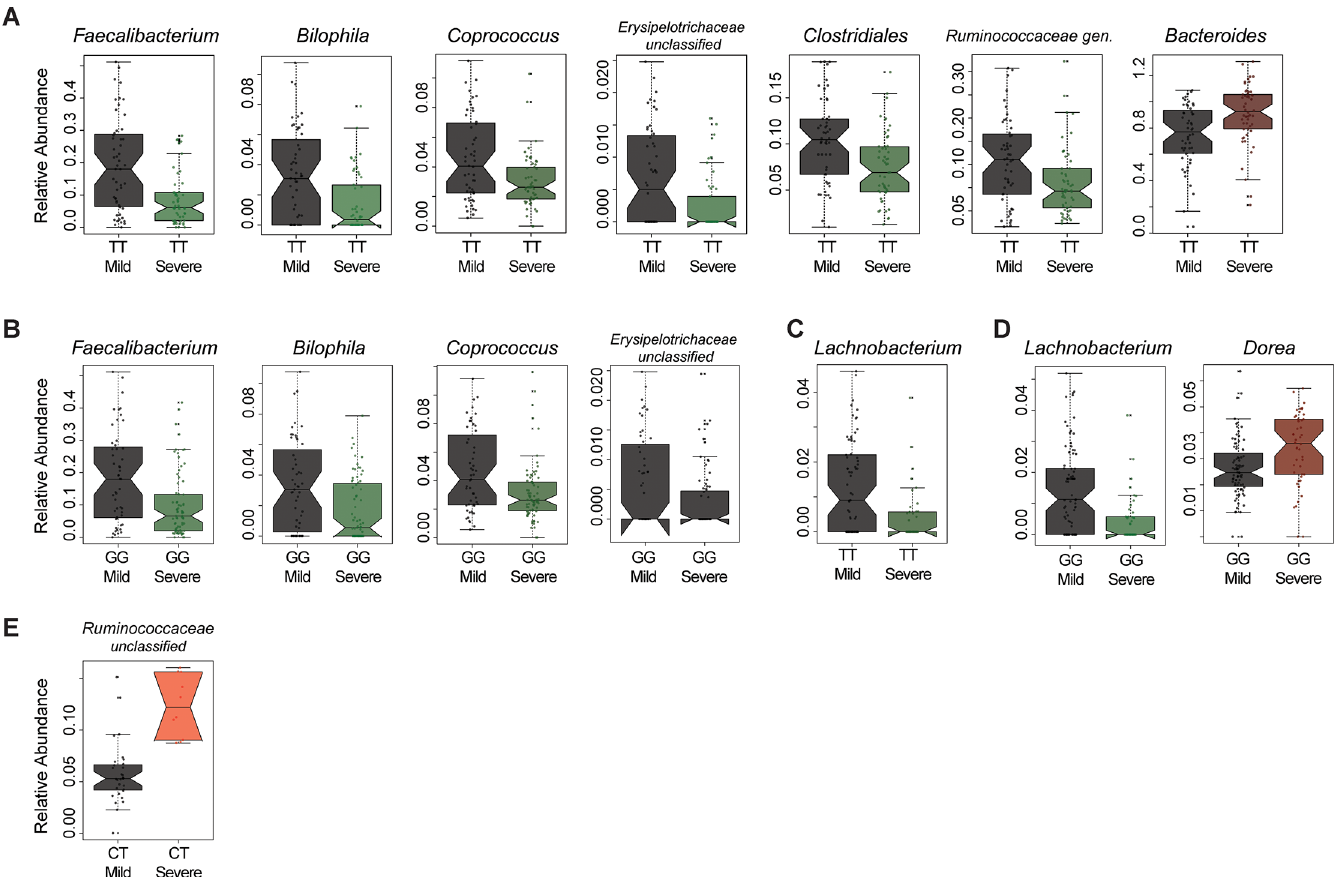
Fig 3. The microbial differences associated with disease severity within same PTPN disease variants. The relative abundance of significantly different microbial taxa (q < 0.05) were plotted according to disease severity status for PTPN2 wild-type variant in (A) and PTPN22 wild type variant in (B) when analyzed for CD. The relative abundance of significantly different microbial taxa (q < 0.05) were plotted according to disease severity status PTPN2 wild-type variant in (C) and heterozygous variant (D) and PTPN22 wild-type variant in (E) when analyzed for UC.